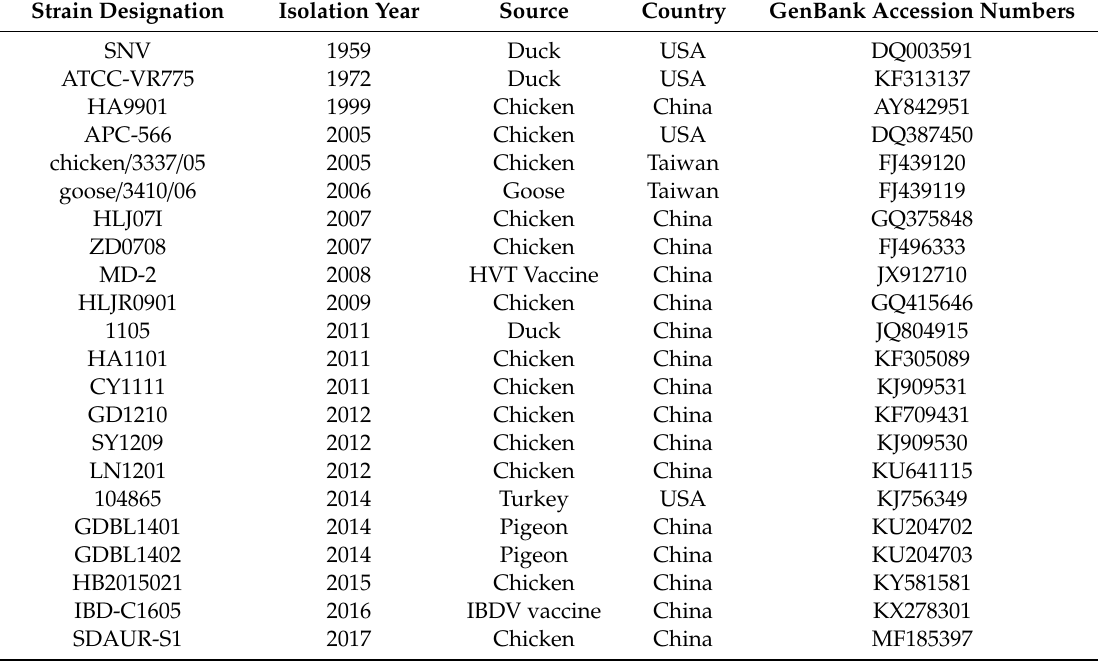
Table 2. Reference reticuloendotheliosis virus (REV) strains used for the phylogenetic